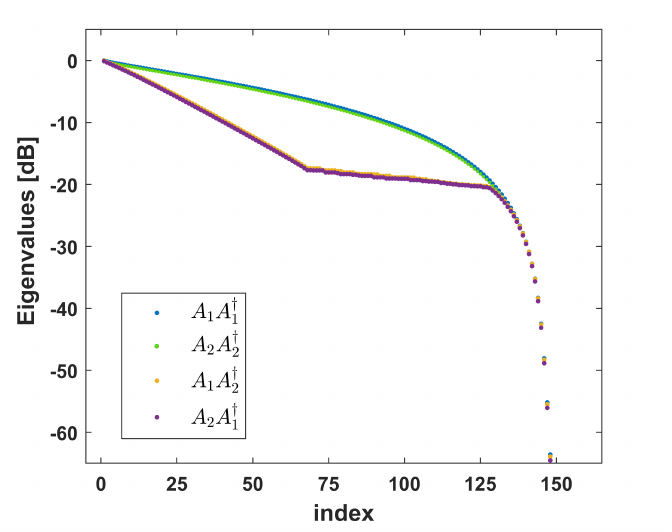
Figure 8. Eigenvalues of the operators A 1 A † z 2 = 5.67 λ , X 1 = 20.75 λ ( η ( X 1 , z 1 ) = 0.9 ) , X 2 = 21.47 λ ( η ( X 2 , z 2 ) = 0.9 )